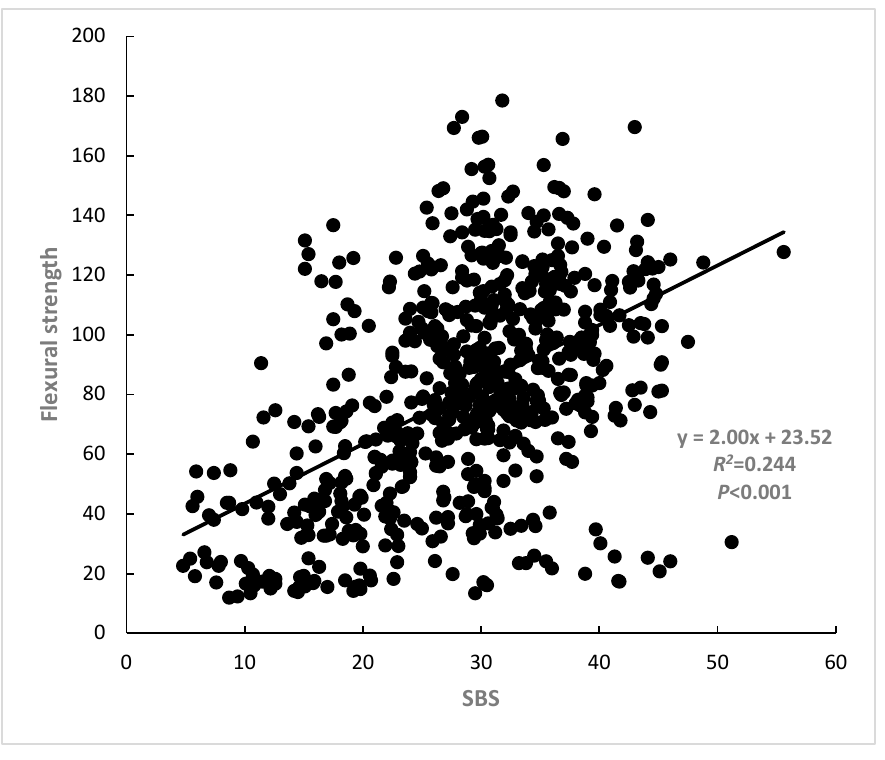
Figure 1. Correlation between flexural strength and shear bond strength to IPS e.max CAD ( R 2 = 0.24, p < 0.001).